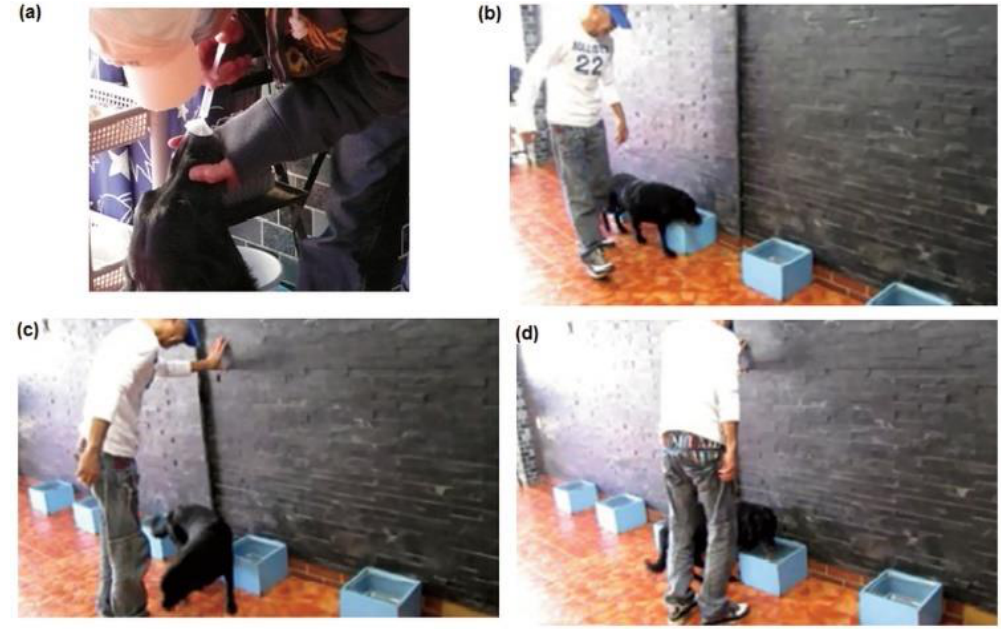
Figure 4. Cancer Detection of Urine Samples. The dog sniffs a 5-mL breath sample from a cancer